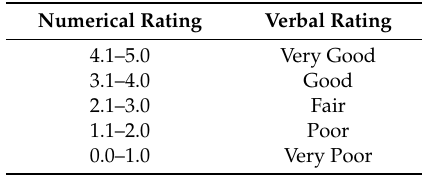
Table 1. Minnesota RQI categories and